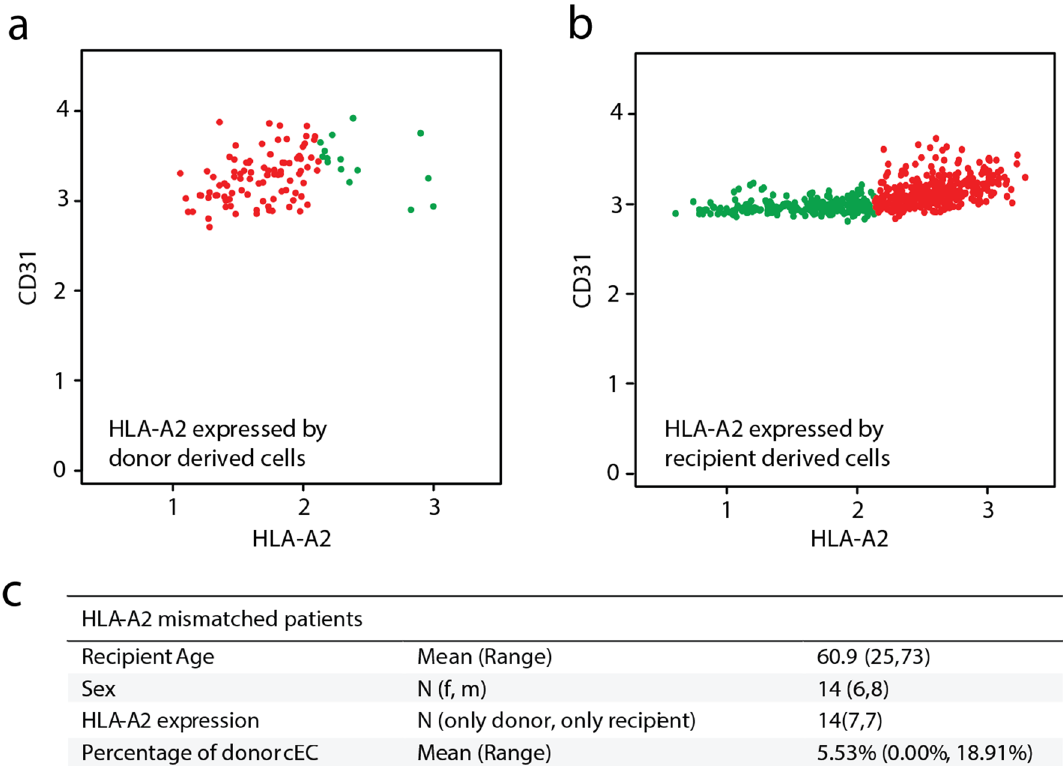
Figure 4. cEC are derived from both the recipient and the donor kidney in transplant patients. Dot plots showing donor and recipient EC in peripheral blood of kidney transplant patient 3 days after transplant; HLA- A2 cEC are shown in green. In (a) , sample from a recipient where only the donor expressed HLA-A2; in (b) , recipient expressed HLA-A2, but not the donor. (c) Overview of recipient and donor